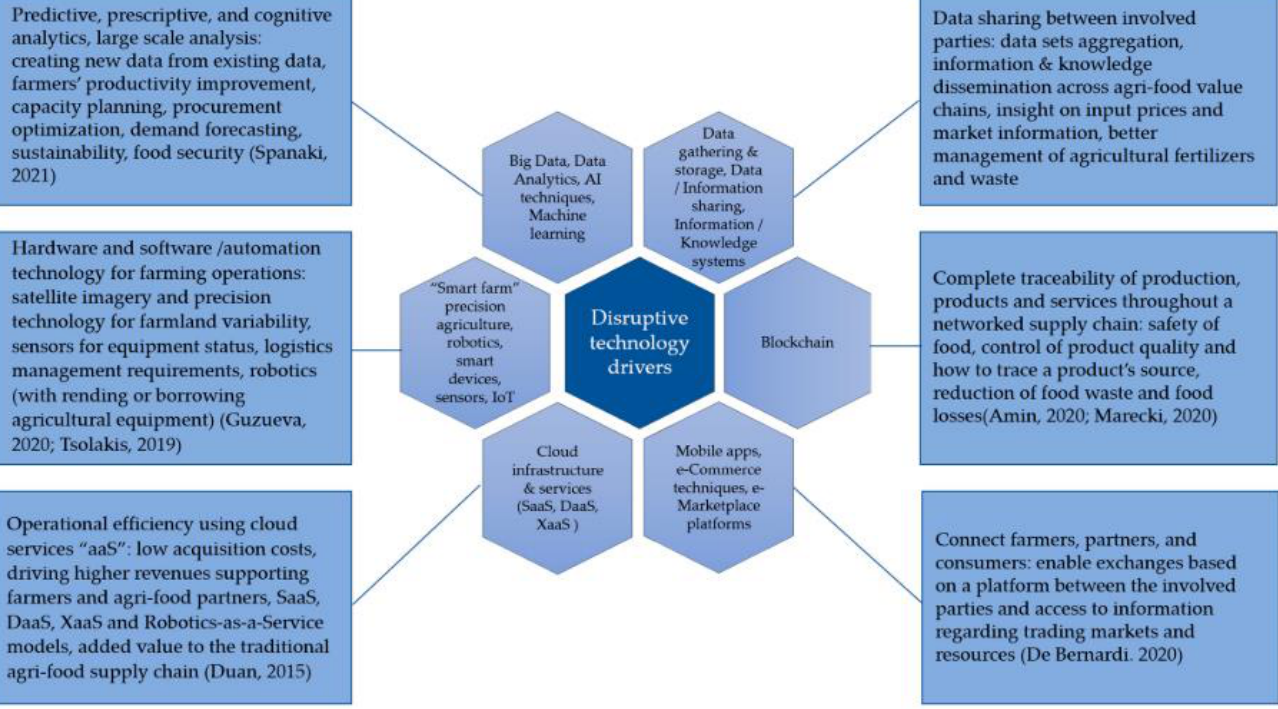
Figure 3. Relationship between disruptive technology drivers in the agricultural domain [81].